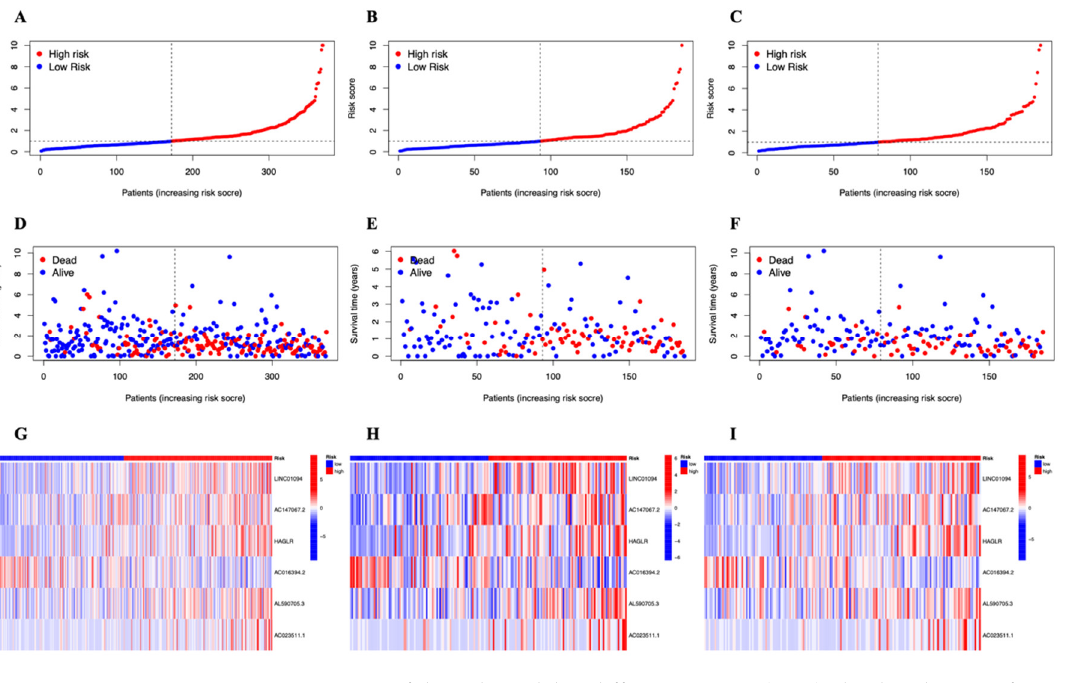
Figure 4. Prognosis of the risk model in different groups. ( A – C ) The distribution of overall survival risk scores in the entire, train, and test sets. ( D – F ) Survival time and survival status in the entire, train, and test sets. ( G – I ) Heat maps of six lncRNA expressions in the entire, train, and test sets.